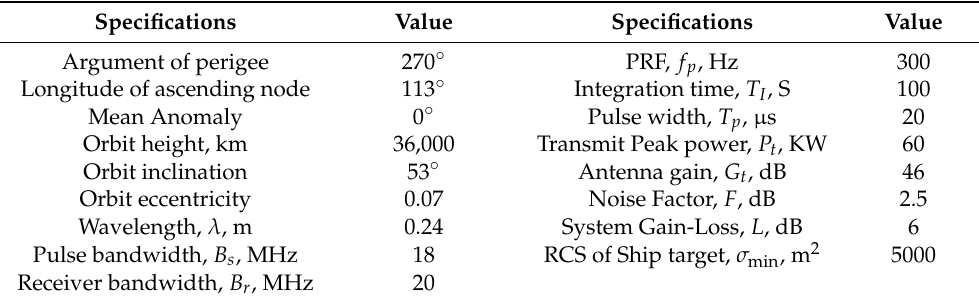
Table 3. GEO SAR system